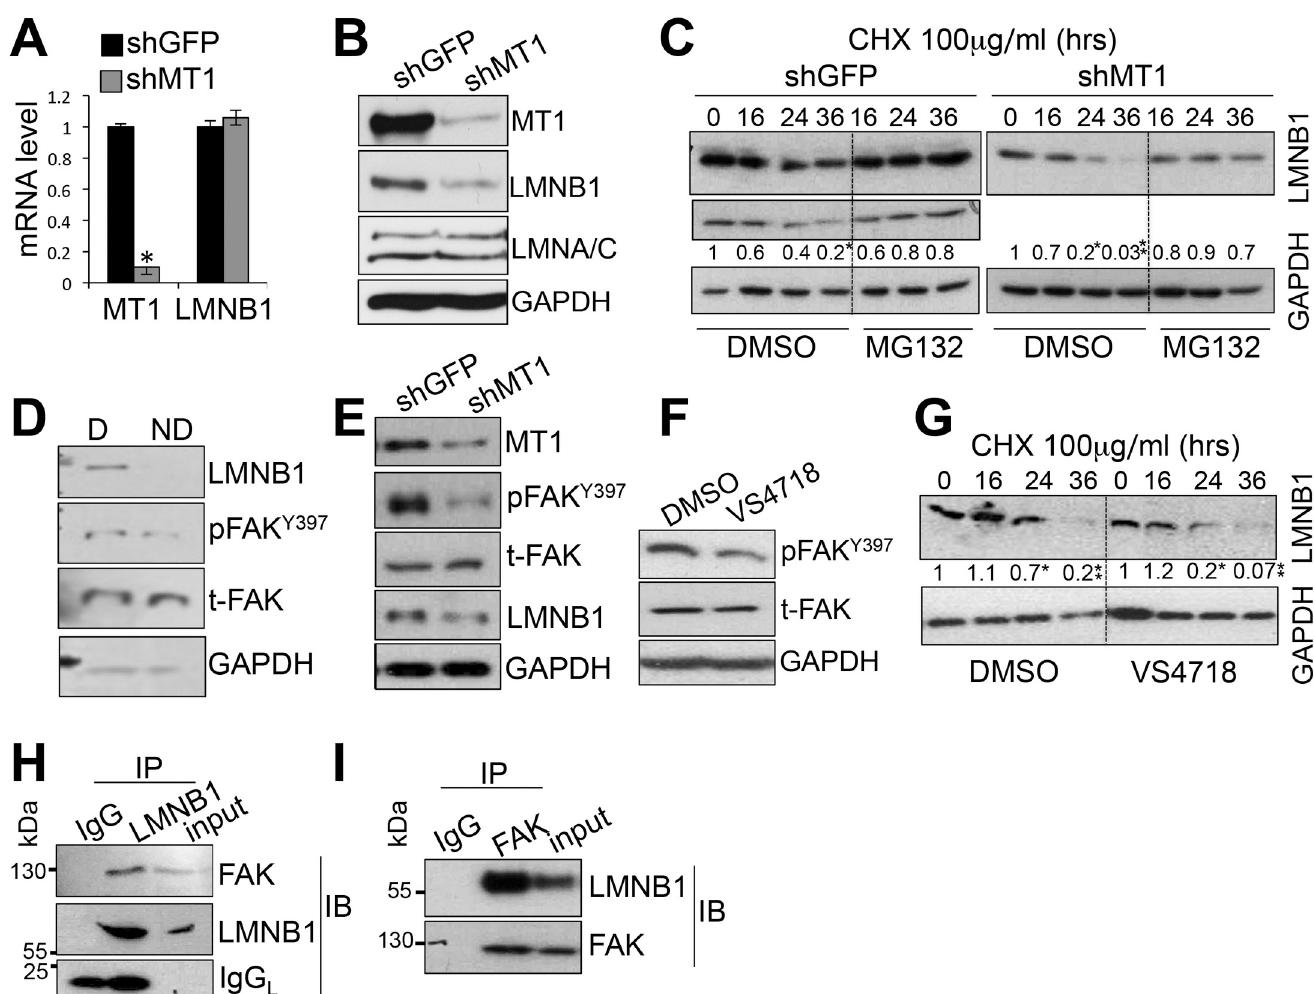
Fig 1. MT1-MMP affects laminB1 stability via integrin β 1/FAK. mRNA levels ( A ), measured by quantitative RT-PCR are the ratio between laminB1 or MT1-MMP mRNA and b-actin mRNA. Protein levels ( B ), assessed by western blotting, of laminB1 (LMNB1), lamina/C (LMNA/C) and MT1-MMP (MT1) in MDA-MB-231 cells expressing shGFP or shMT1-MMP. C) Western blotting showing levels of laminB1 in MDA-MB-231 cells expressing either shGFP or shMT1-MMP treated with 100 μ g/ml cycloheximide for the time indicated and with 50 μ g MG132 (proteasome inhibitor). Rates of degradation are shown. These are the mean of two independent experiments. Values are the ratio between band intensity of LMNB1 and GAPDH, evaluated by ImageJ. Time 0 (T0) was normalized to 1. � p < 0.05, �� p < 0.001, Student’s t test D) Levels of LMNB1, phspho-FAK Y397 , total FAK and GAPDH, used as loading control, assessed by western blotting in total lysates of cells seeded in degradable (D) or non-degradable (ND) hydrogels. E) LMNB1, FAK Y397 and total FAK assessed by western blotting in total lysates of cells expressing shMT1-MMP. F) Levels of phospho-FAK Y397 , assessed by western blotting, in MDA-MB-231 cells treated for 36 hours with the FAK inhibitor VS4718 used at 400nM. G) Inhibition of FAK activity by VS4718 accelerates LMNB1 degradation. LaminB1 levels were assessed by western blotting in cells treated with DMSO or VS4718 in the presence of cycloheximide (100 μ g/ml), for the time indicated. Rates of degradation are shown and are the mean of two independent experiments. Values are the ratio between band intensities of LMNB1 and GAPDH, measured by ImageJ. Time 0 (T0) was normalized to 1. � , �� p < 0.001, Student’s t test. H-I) Representative co-immunoprecipitation assays–(H) IP: Immuno-precipitation of laminB1. IB: Immunoblotting with anti FAK and anti LMNB1. LaminB1 enrichment versus input: 4.6 +/- 1; FAK enrichment versus input: 6.4 +/- 1.05. (I) IP: Immuno-precipitation of FAK. IB: Immunoblotting with anti FAK and anti LMNB1. LaminB1 enrichment versus input: 5.5 +/- 0.4; FAK enrichment versus input: 2.9 +/- 0.2. IgG was used as negative control. IgG L in Fig 1H is the light chain of IgG. IPs were performed twice.